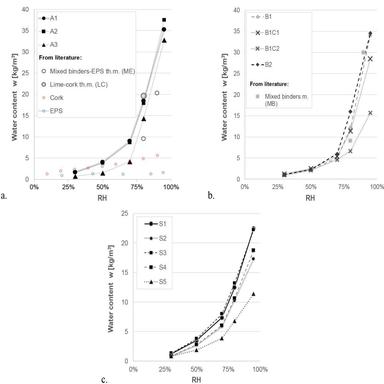
Sorption isotherms of (a) thermal mortars, (b) regularization mortars with and without paints and (c) whole systems, compared to other results from the literature: cork and EPS , ME, MB and LC.